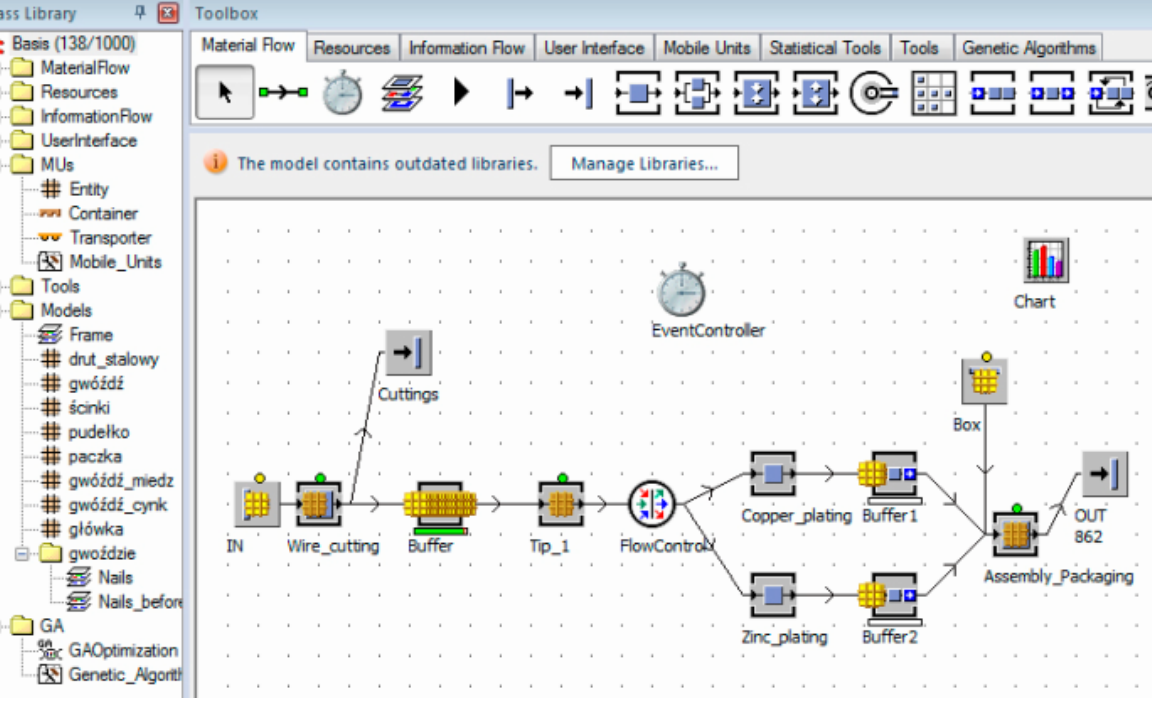
Figure 2: Example of production process designed using Tecnomatix Plant Simulation [17].